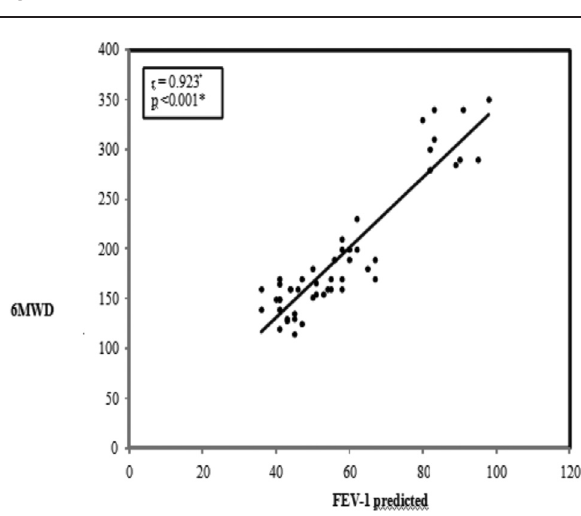
Correlation between bode index and DEXA scan.